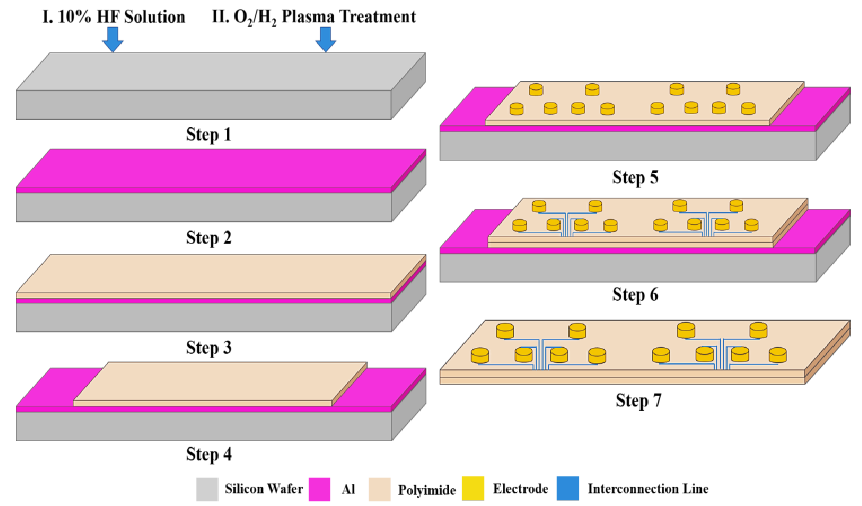
Figure 1. The fabrication schematic of the proposed flexible polyimide-based multichannel microelectrode arrays (MEAs).